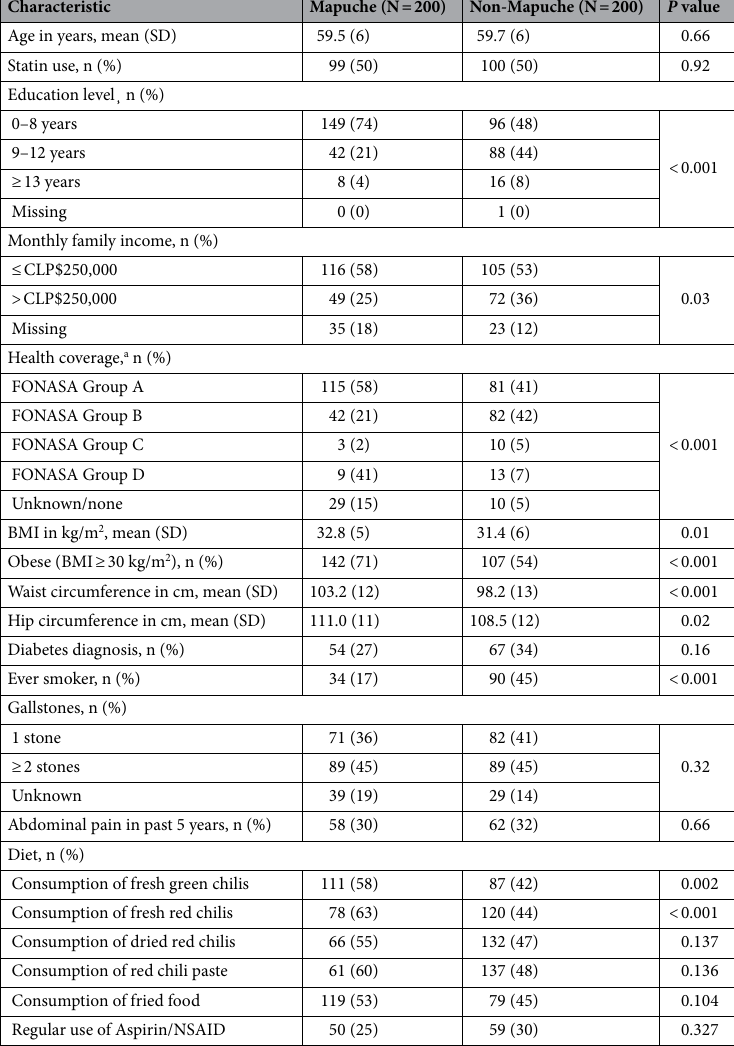
Table 1. Demographic and medical characteristics of Mapuche and non-Mapuche Chilean women sampled from the Chile BiLS cohort (N = 400). Values do not add up to the total due to missingness for the following number of participants: statin use—1; education level—1; monthly family income—56; health insurance coverage—4; smoking status—1; gallstones—1; abdominal pain—14; diet—3. BMI body mass index, CLP Chilean pesos, cm centimeters, FONASA Fondo Nacional de Salud (Chile’s public health insurance system), kg kilograms, m meters, n number, SD standard deviation. a FONASA Groups A–D are hierarchical classifications used to determine the proportion of healthcare costs covered by the government, based on taxable individual income. FONASA Group A has the lowest income level and receives the highest level of governmental coverage of healthcare costs.